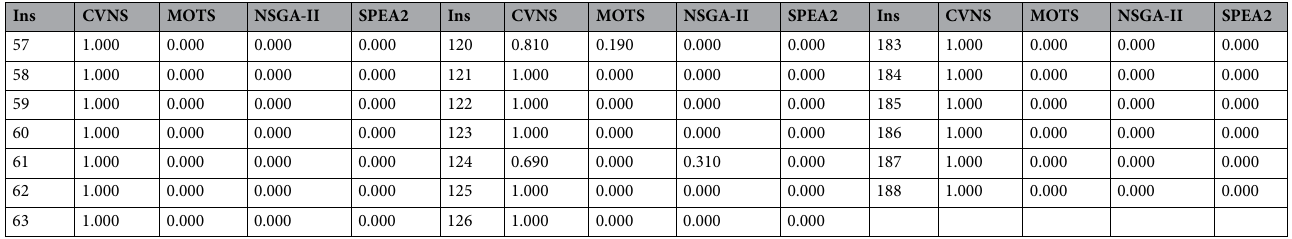
Table 3. Computational results of four algorithms on metric ρ